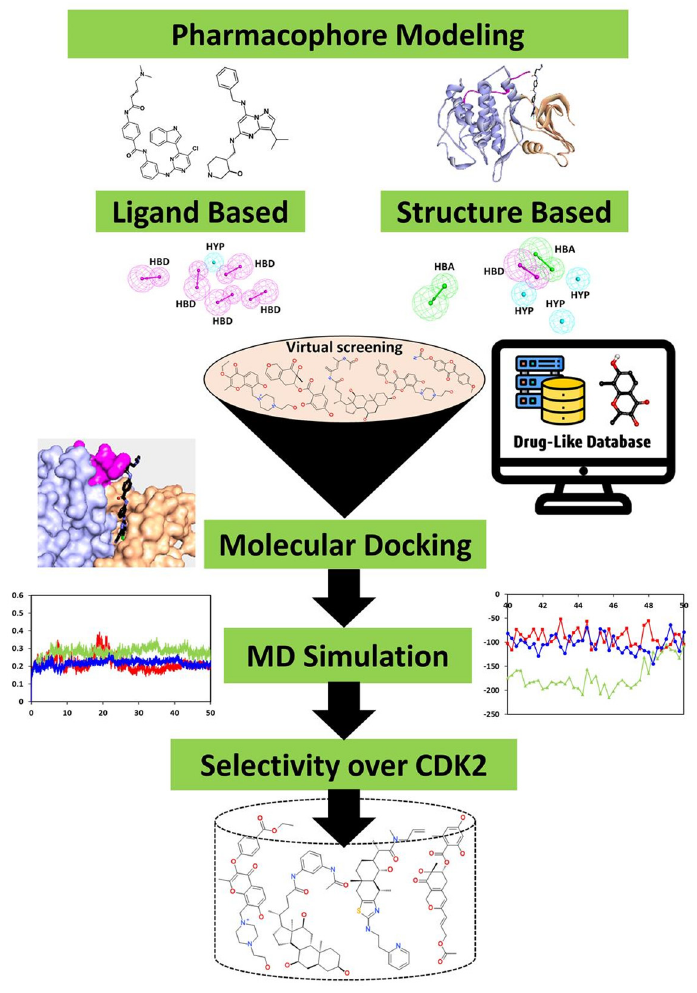
Figure 1. Schematic workflow for ligand and structure-based drug design used in the present study.